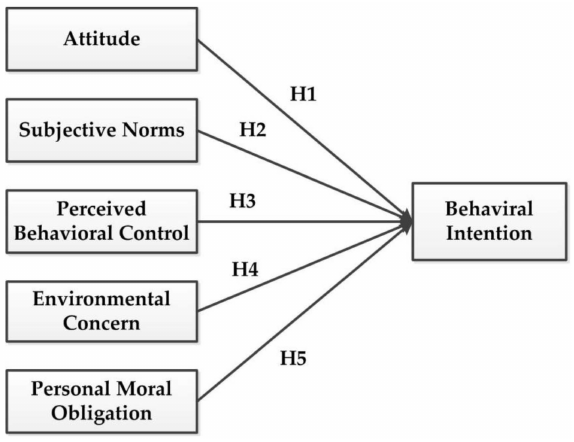
Figure 1. Extended theoretical